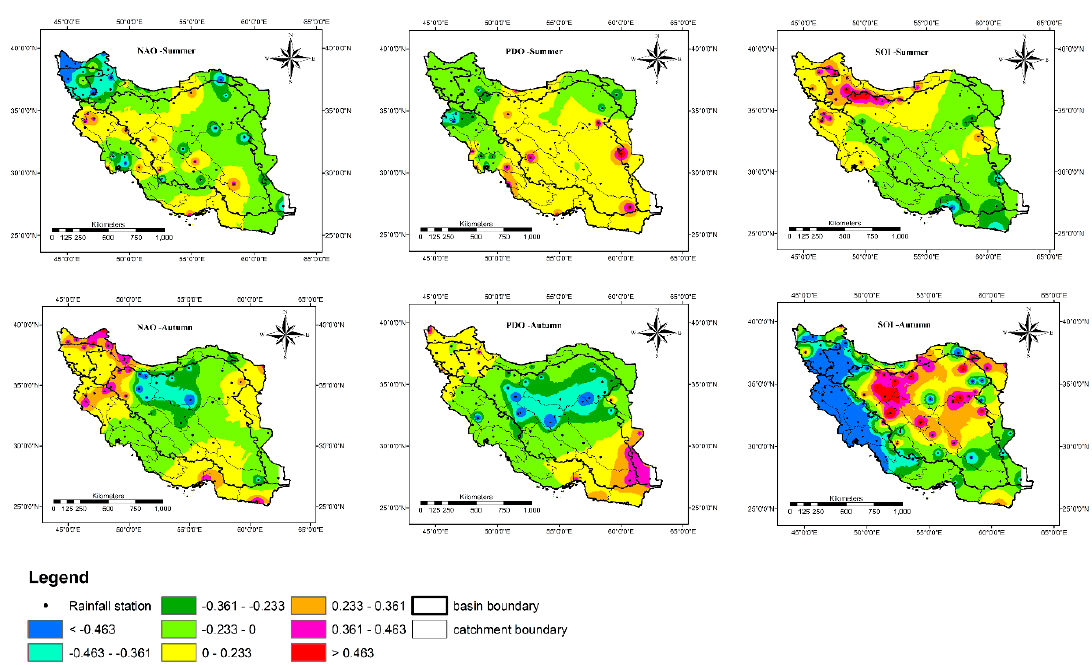
Figure 4. Spearman correlation between NAO, PDO, and SOI and seasonal precipitation.